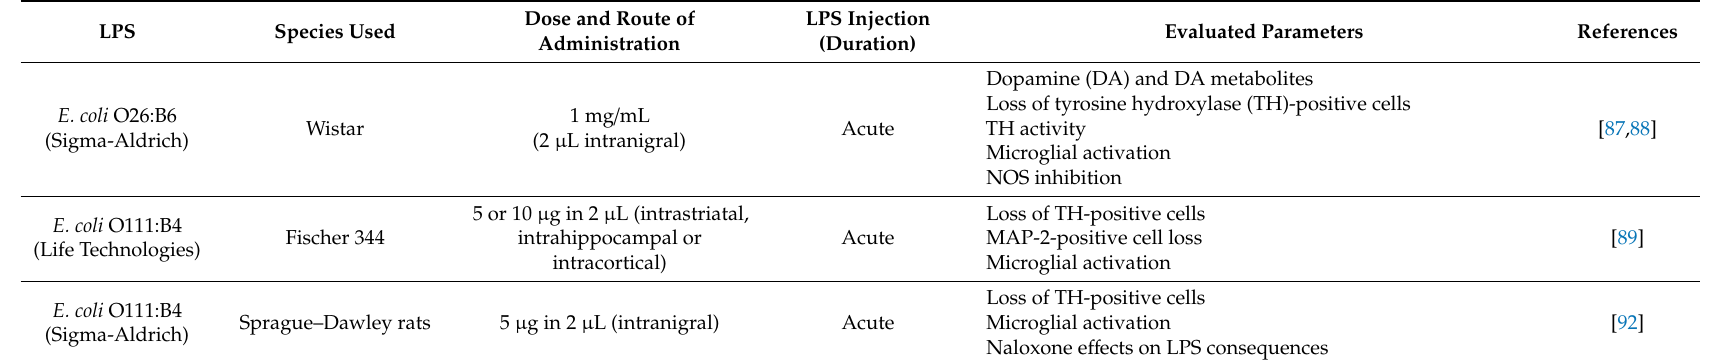
Table 3. LPS source, species used, dose and route of administration, duration, evaluated parameters of models of central LPS challenges for the elucidation of Parkinson’s disease